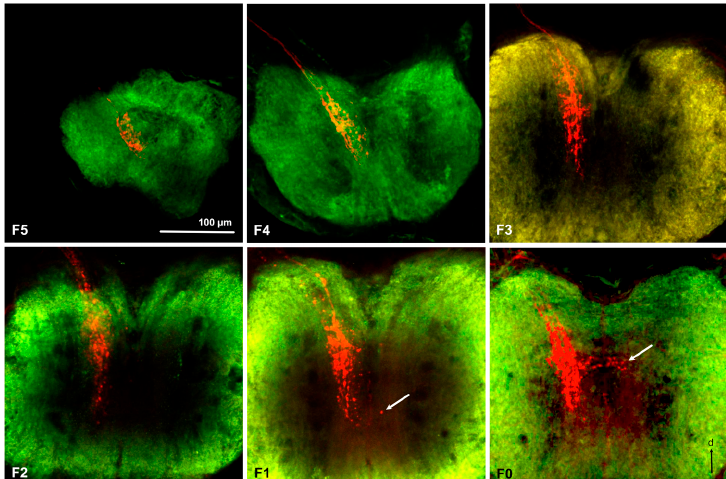
Figure 5. Projections to the gnathal ganglion in the 6 investigated nymphal instars of Libellula depressa (F5/F0 instars) . Note that all maximum z-projections of stacks of optical sections (over 14 μ m in F5, 26 μ m in F4, 11 μ m in F3, 14 μ m, 17 μ m in in F1, and 26 μ m in F0) were taken at the same scale. Arrow indicates contralateral branches of the axons in the F0 and F1 instars. d dorsal. Microruby stained axons in red and background staining with the anti-synapsin antibody in green.